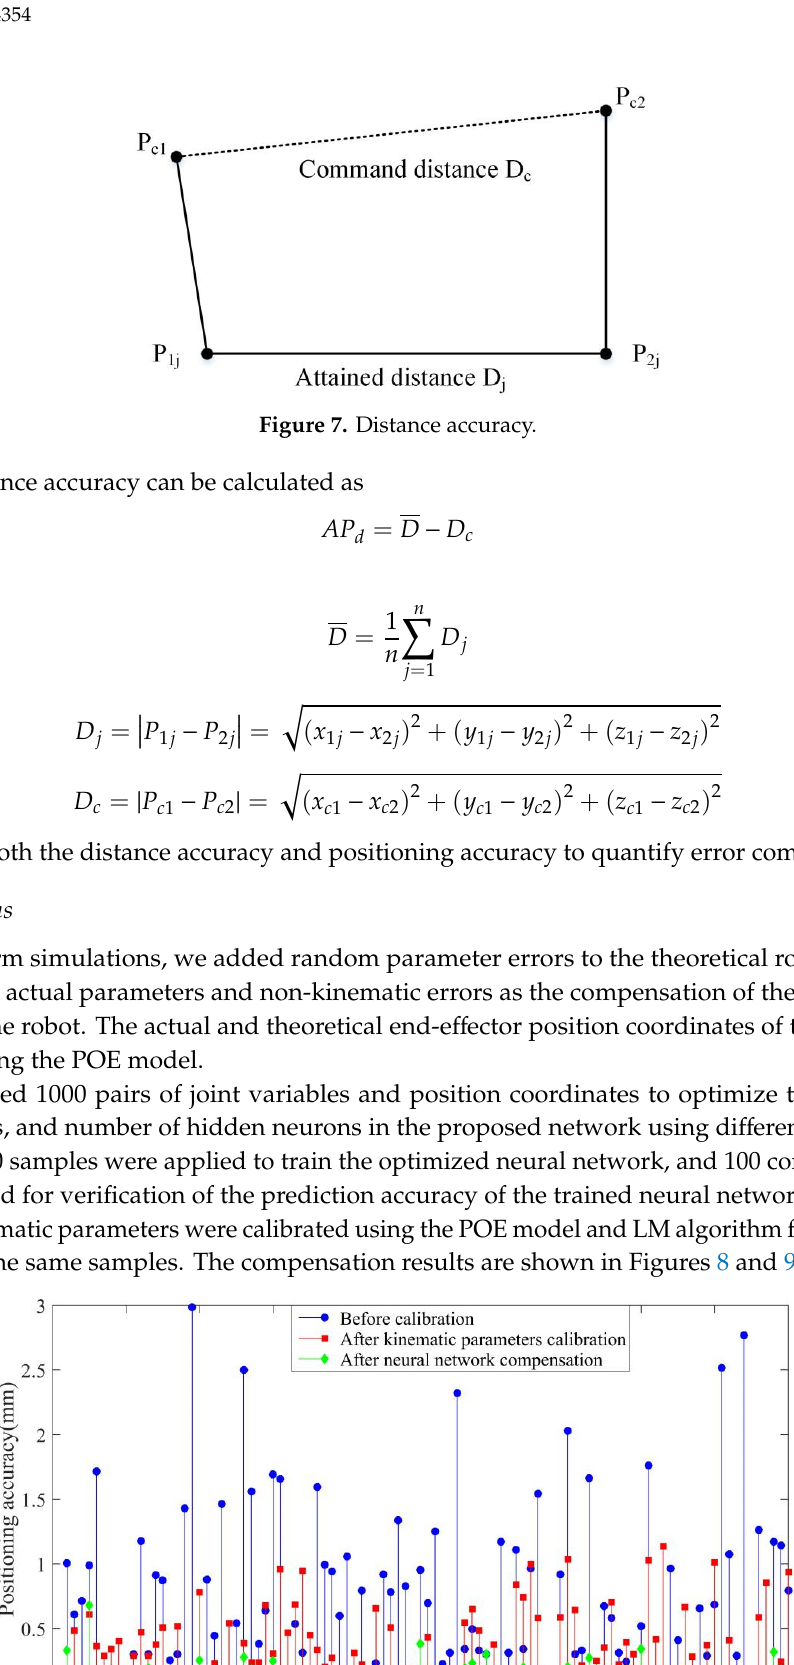
Figure 9. Distance accuracy of the simulations. Compared to the calibration method, the proposed neural network optimized using differential evolution provides better compensation. The maximum distance accuracy is improved from 3.1760 mm to 0.7743 mm, and the average distance accuracy is improved from 1.1118 mm to 0.1564 mm by using the proposed network. The maximum positioning accuracy is improved from 3.1760 mm to 0.7743 mm and the average positioning accuracy is improved from 0.7411 mm to 0.1007 mm by using the proposed algorithm. As summarized in Tables 1 and 2, the proposed method has the best absolute positioning accuracy and distance accuracy.